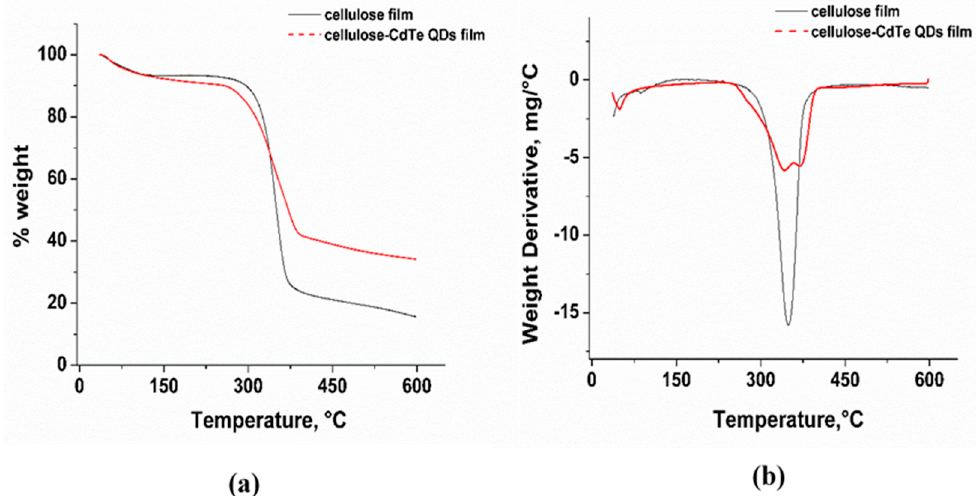
Figure 5. ( a ) TG profiles of cellulose film and cellulose-CdTe QDs film and corresponding ( b ) derivative thermogravimetric (DTG) profiles.